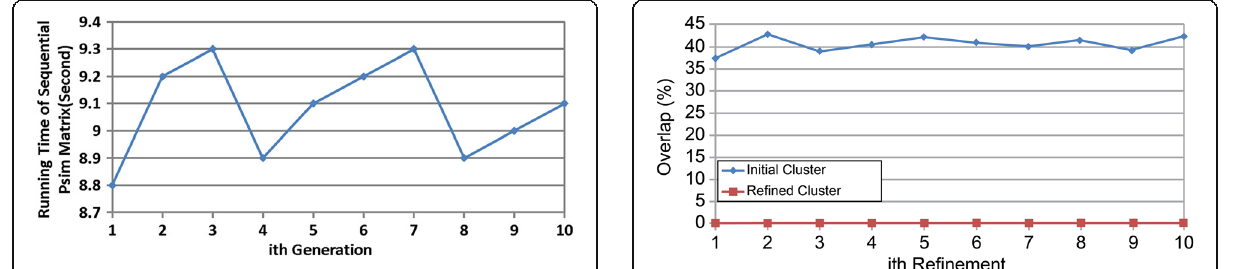
Fig. 2 Running time for producing sequential Psim matrix ten times